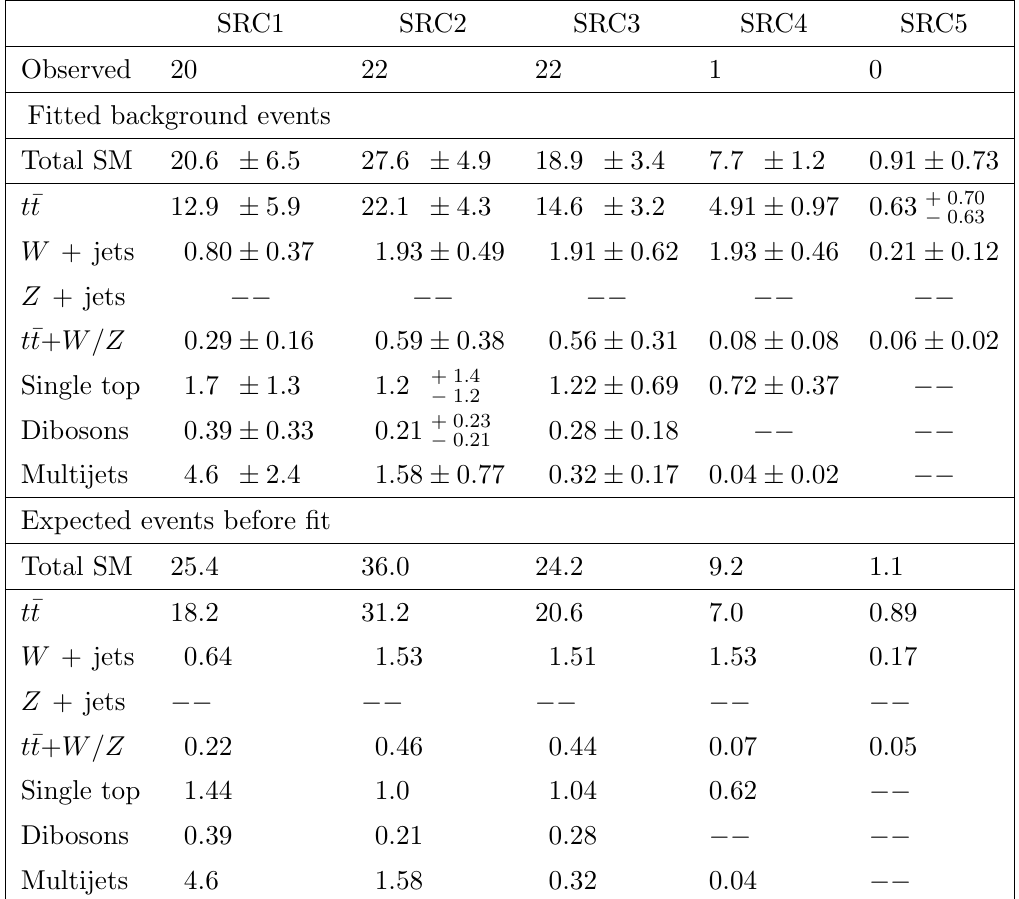
Table 12. Observed and expected yields, before and after the (cid:12)t. The uncertainties include MC statistical uncertainties, detector-related systematic uncertainties, and theoretical uncertainties in the extrapolation from CR to